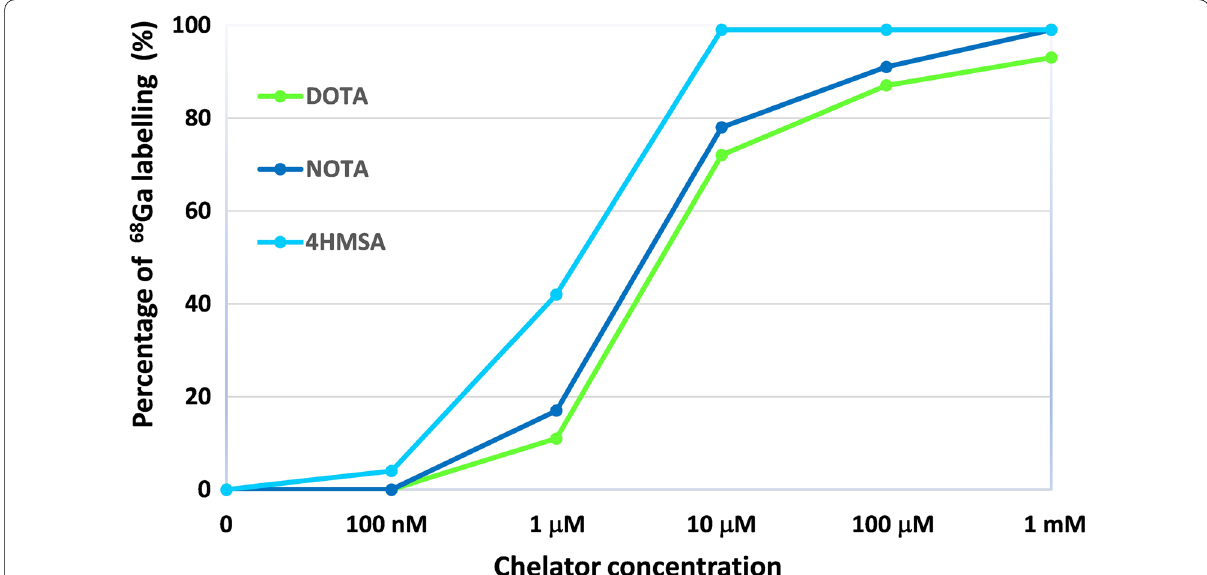
Fig. 4 Percentage of 68 Ga labeling with 4HMSA, NOTA and DOTA as a function of chelator concentration. A complete complexation of 68 Ga‑4HMSA was observed at a concentration of 10 μM after 5 min incubation at room temperature, while high RCYs were achieved at concentration of 1 mM after 15 min at room temperature for 68 Ga‑NOTA and 30 min at 80 °C for 68